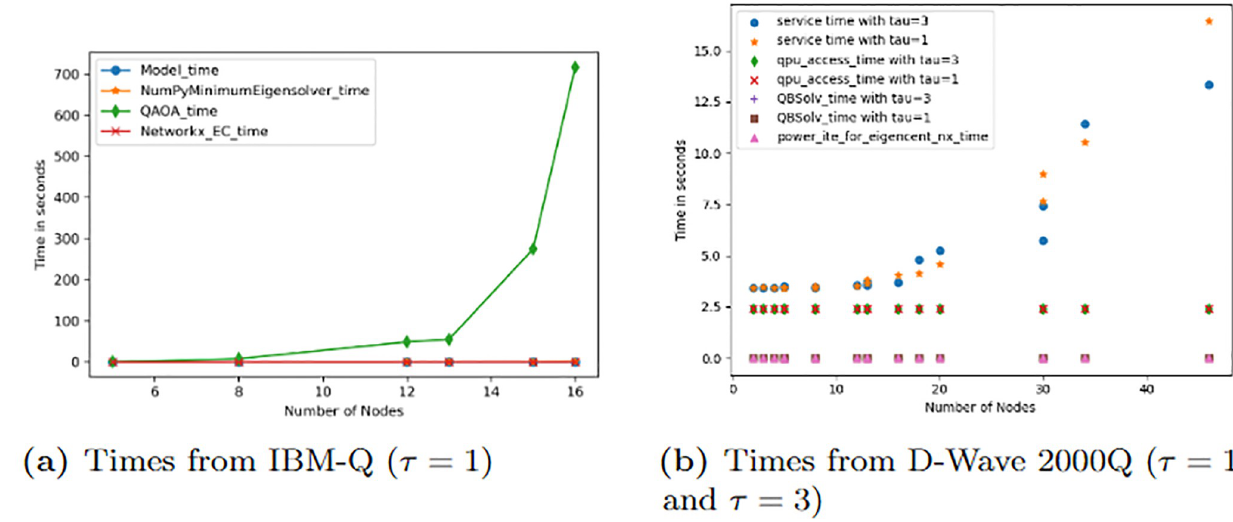
Fig 8. Time plots. A plot of the number of nodes against the time in seconds taken to solve the QUBO problem P on (a) the IBM-Q using (1) the classical exact numpy minimum eigensolver, (2) the QAOA algorithm on a QASM simulator, and using the power iterative method in NetworkX to solve the EC problem, and on (b) the D-Wave 2000Q using (1) the classical qbsolv solver which employs the tabu algorithm on the D-Wave system, (2) the QA algorithm and using the power iterative method in NetworkX to solve the EC problem.